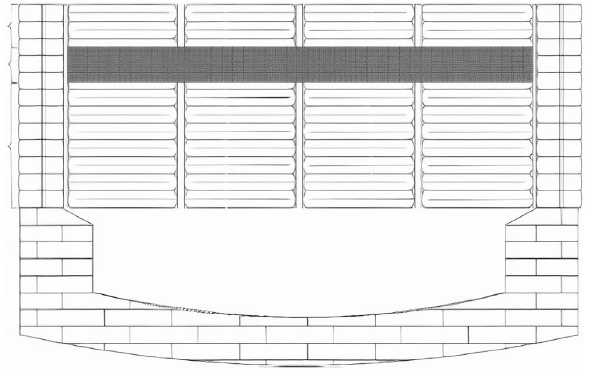
Fig. 18 Schematic representation of an EAF equipped with a TPV system [17]